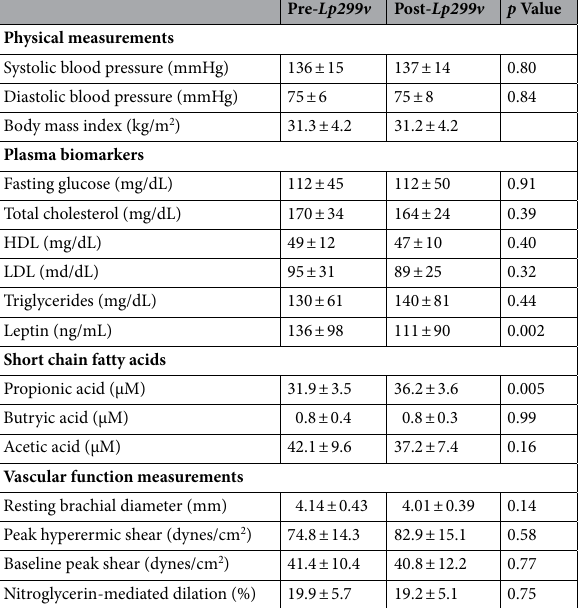
Table 1. Subject characteristics. *All data presented as mean ± SD. N = 6 for Nitroglycerin-Mediated Dilation. N = 14 short chain fatty acid measurements. N = 15 for all other comparisons. p Values derived from Paired t-Test. † Lp299v = Lactobacillus plantarum 299v.